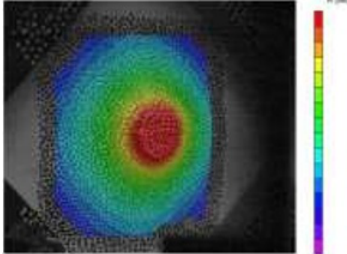
Fig. 9. Test configuration for the impact tests